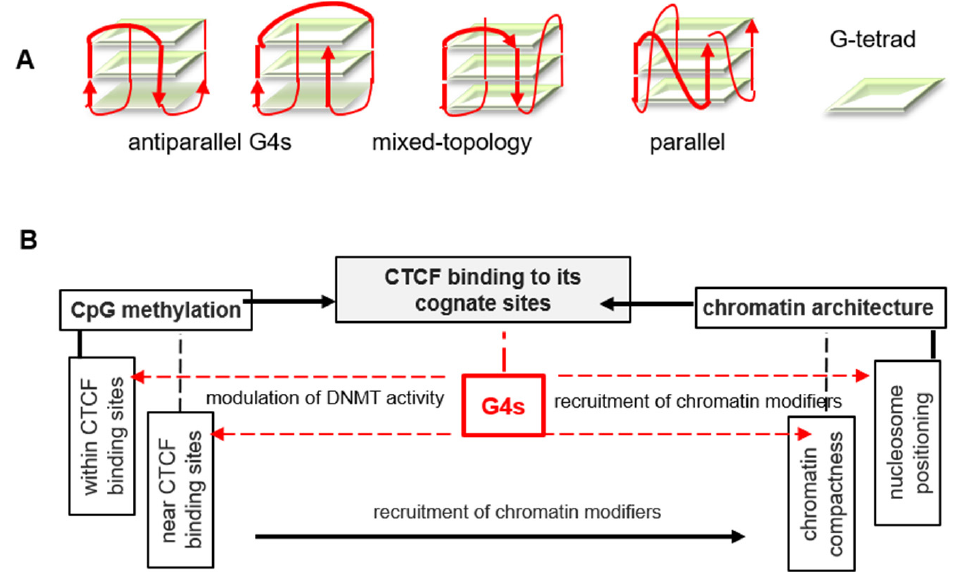
Figure 1. G-quadruplex (G4) structures and their presumed role in CTCF positioning. ( A ) Schematic representation of G4s. ( B ) Summary of the major factors that affects CTCF binding to genomic DNA. Dashed red lines indicate presumed links that are verified in this study.